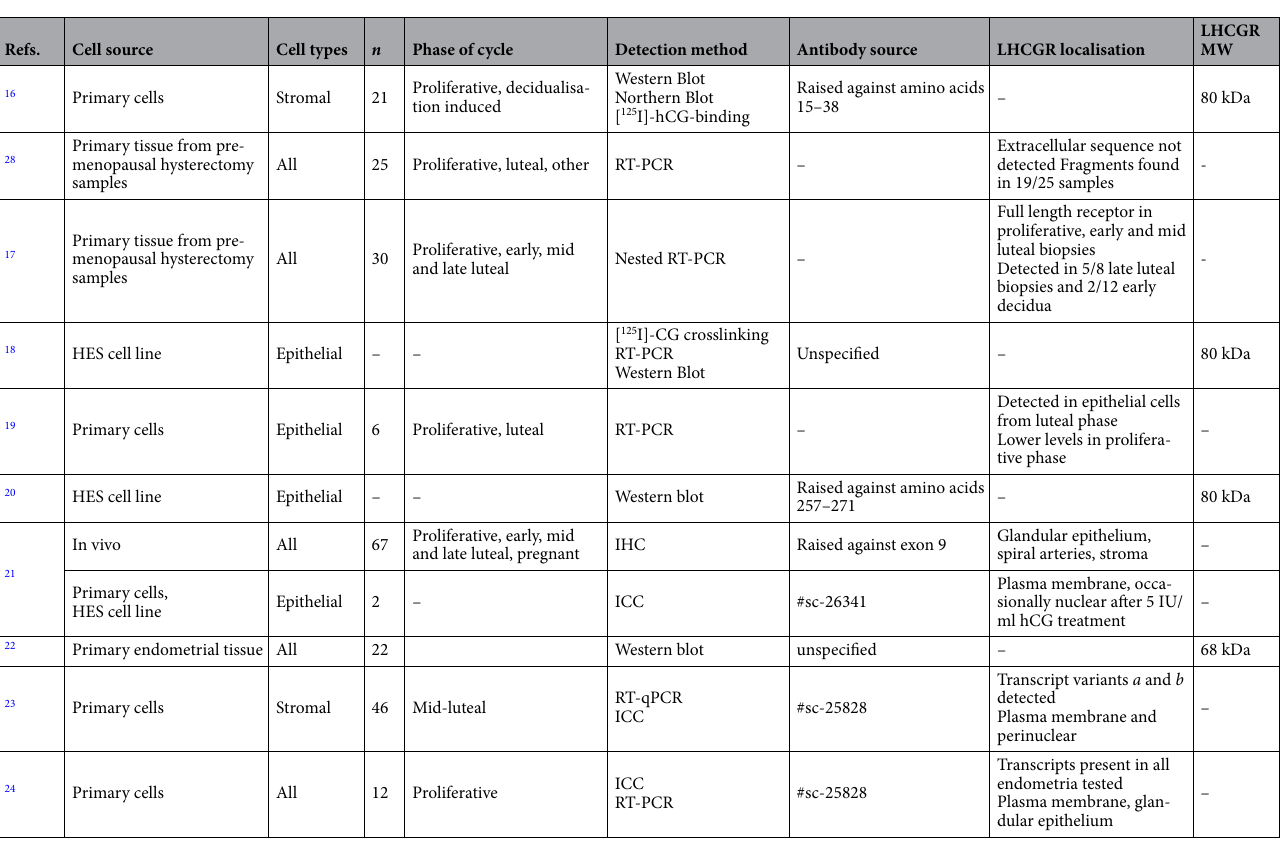
Table 1. Expression of LHCGR in endometrial cells and